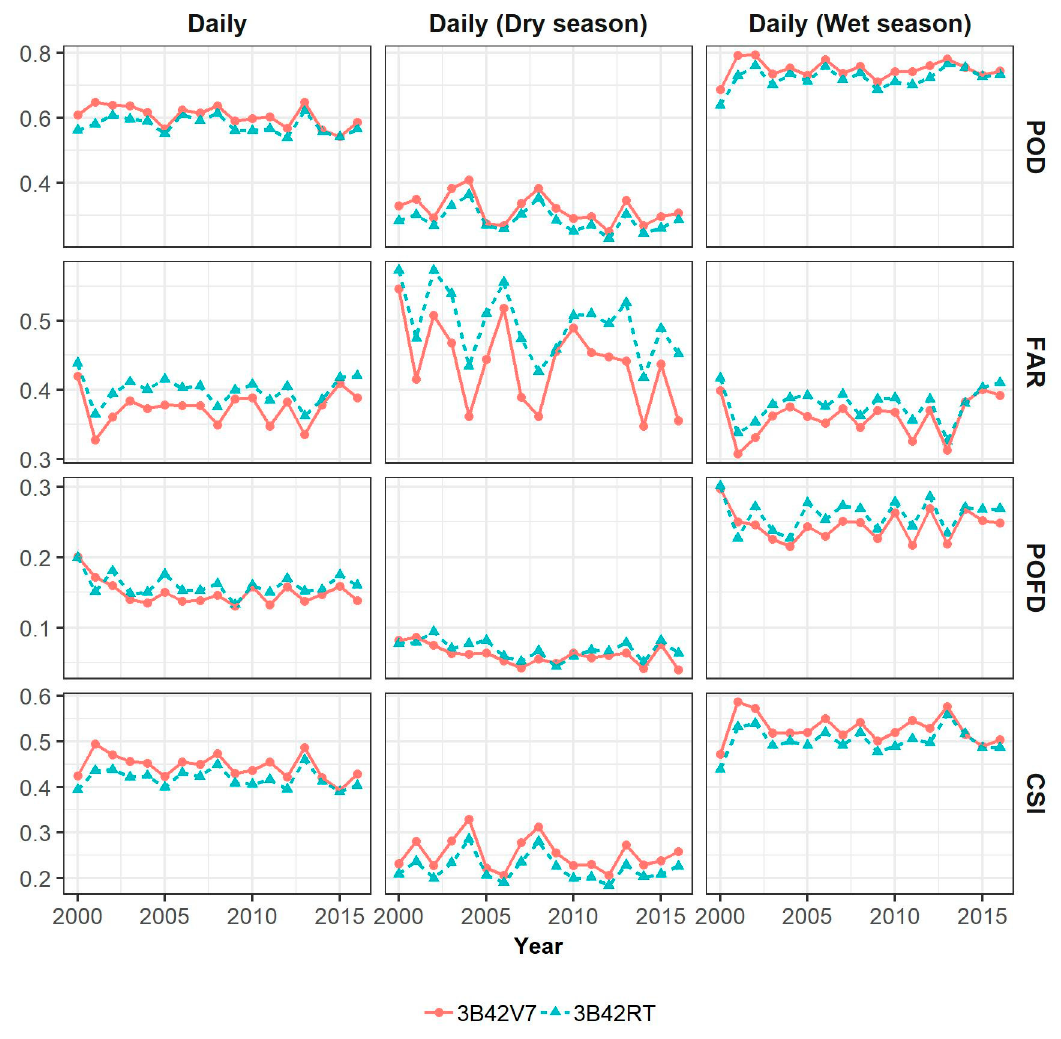
Figure 5. Average rainfall detection measurement of TMPA 3B42V7 and TMPA 3B42RT over the Red–Thai Binh River Basin from March 2000 to December 2016.